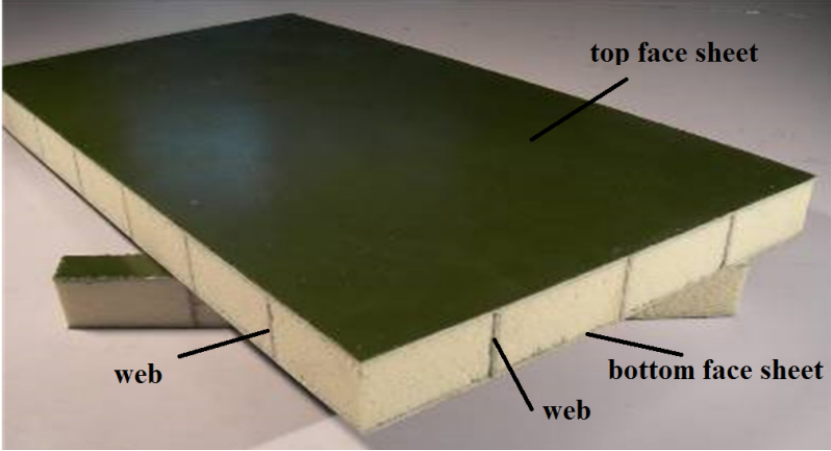
Figure 1. Sandwich lattice composite panel reinforced with crisscross webs.